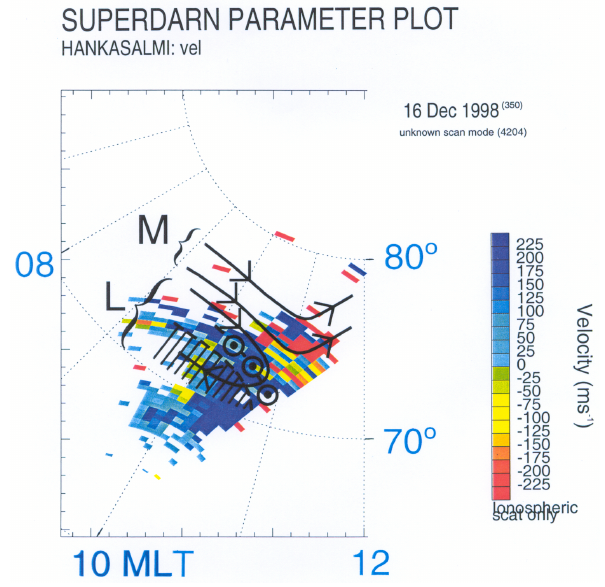
Fig. 6. Spatial plot of line-of-sight ion velocities within the total field of view of the CUTLASS radar for 0736 UT plotted in an MLT/MLAT reference system. The 70 ◦ and 80 ◦ MLAT circles, as well as the MLT meridians from within 0700–1200, are marked. A convection pattern with merging (M) and lobe (L) cells is indicated by arrowed curves. Hatched area marks the cusp auroral brighten- ing. Small dotted circles mark the location of upward field aligned current/transient polar arc (see also Fig. 8).